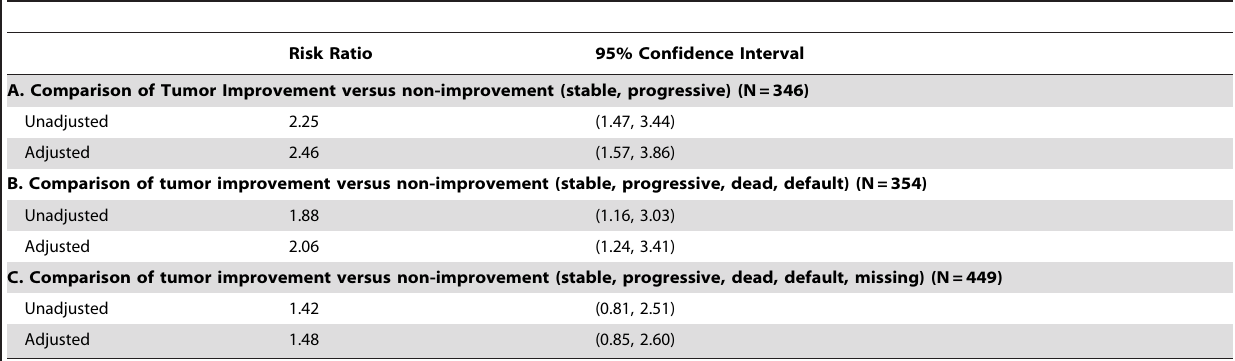
Table 3. A Comparison of Bleomycin/Vincristine versus Vincristine Monotherapy on the Probability of Tumor Improvement at 40– 42